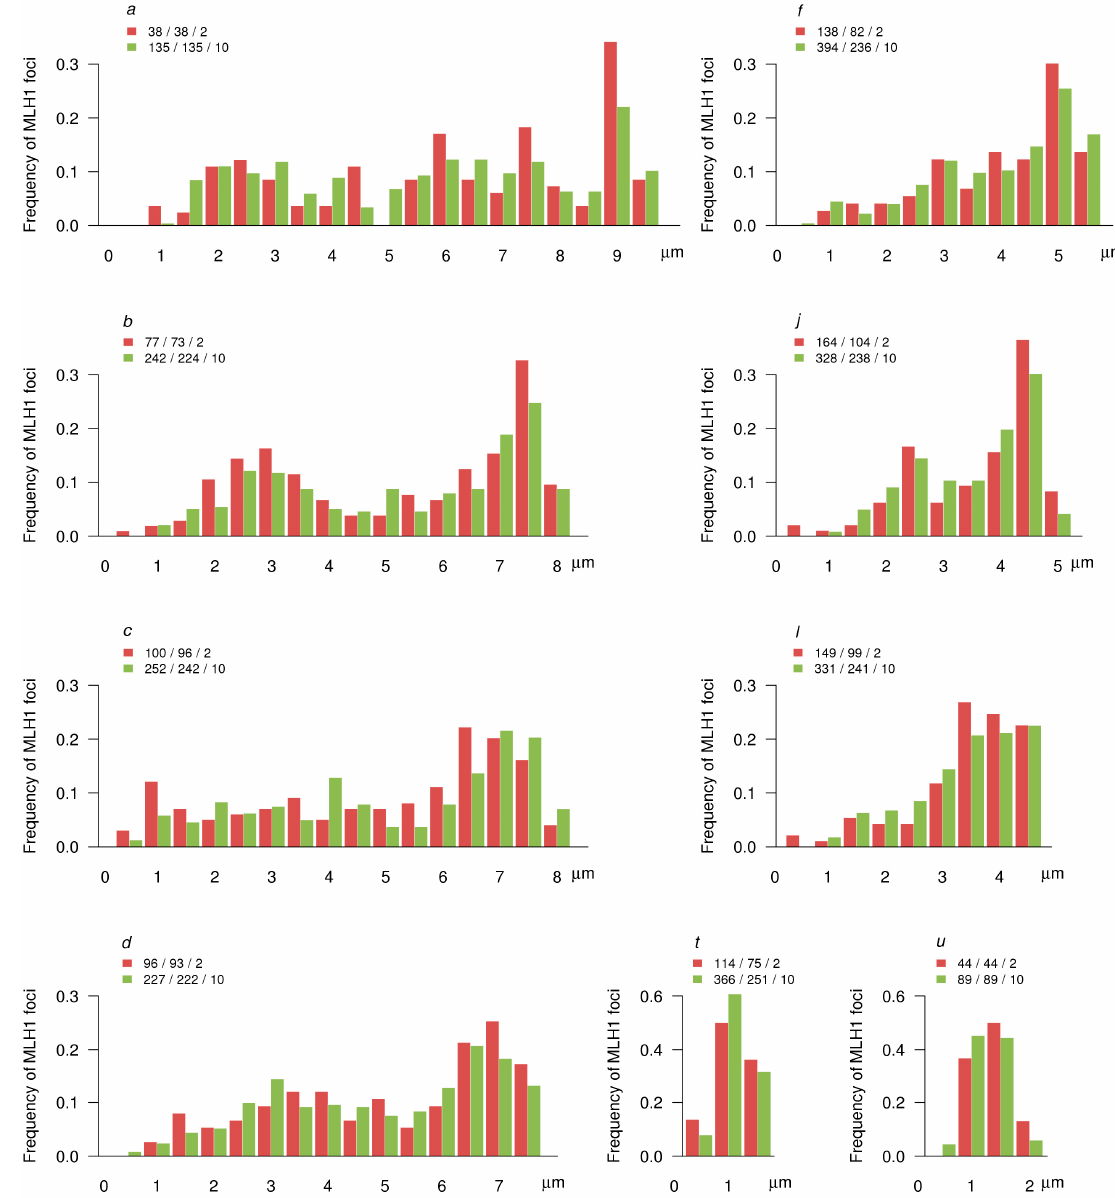
Figure 7. Distribution of MLH1 foci along the arms of invariable chromosomes. The X-axis shows the position of MLH1 foci in relation to the centromere (marked by 0) for the synaptonemal complexes (SC) of the particular arm (indicated at the top of each graph) in bivalent/trivalent carriers (red) and complex heterozygotes with a CVIII configuration (green). The labels on the X-axis are separated by 1 µm of the SC. The Y-axis indicates the frequency of MLH1 foci in each 0.5 µm interval. The numbers in the legends above each plot show the number of MLH1 foci/arms/specimens plotted.